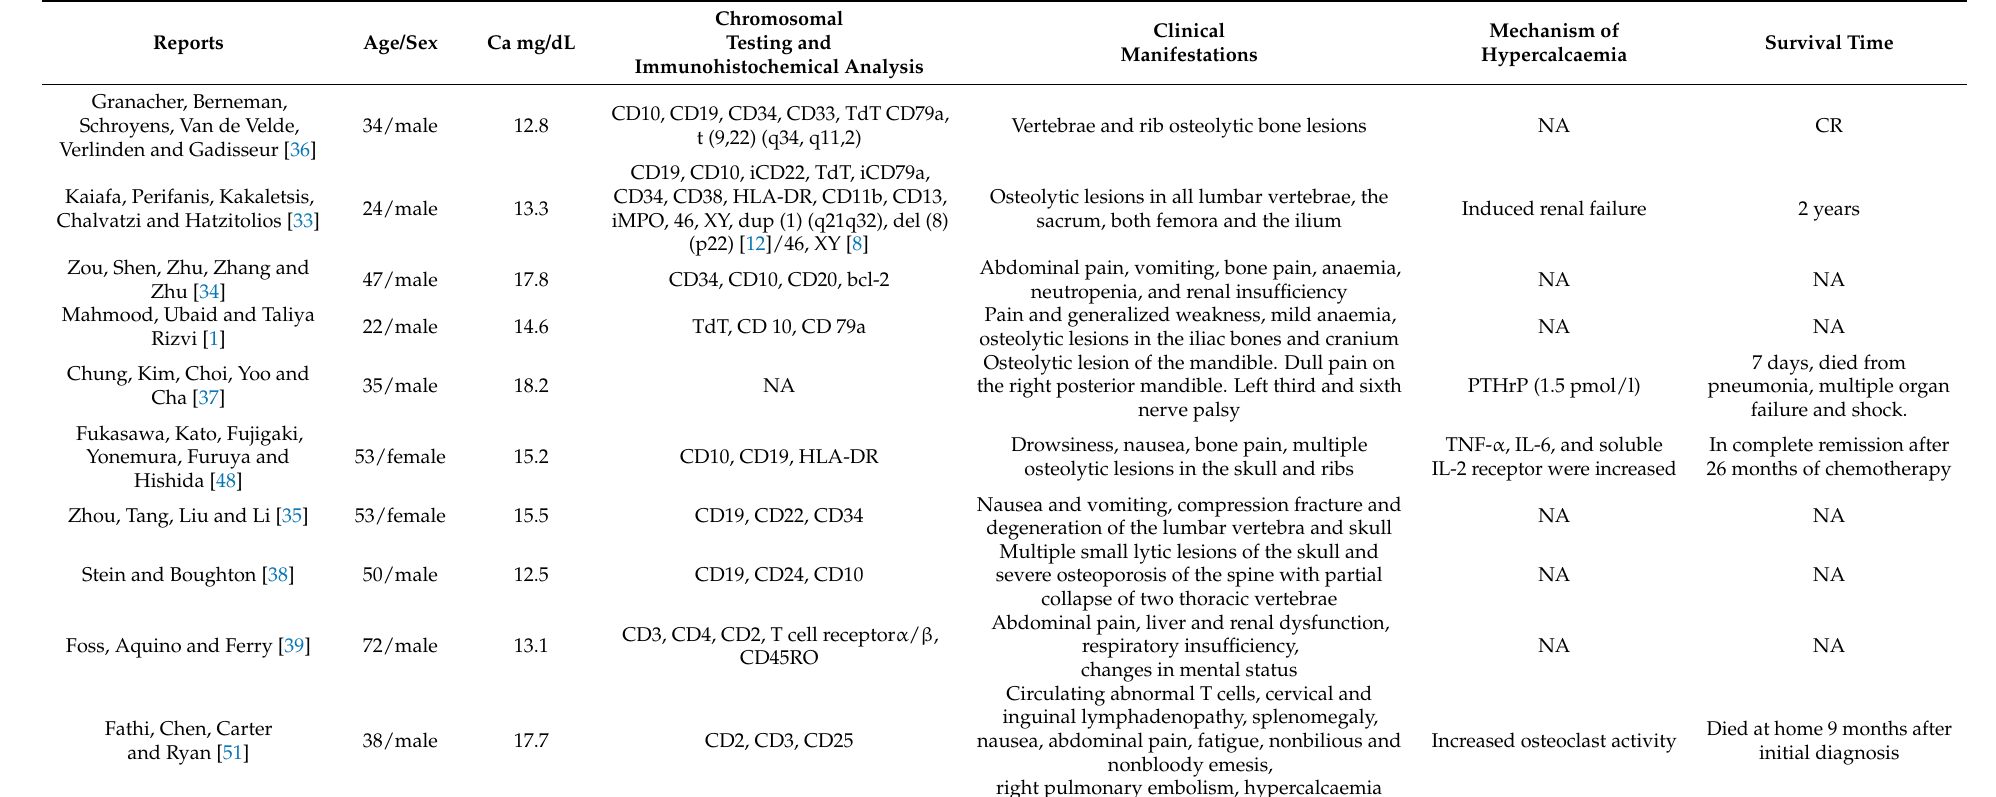
Table 3. Hypercalcaemia in adult patients with ALL: a review and comparison of the